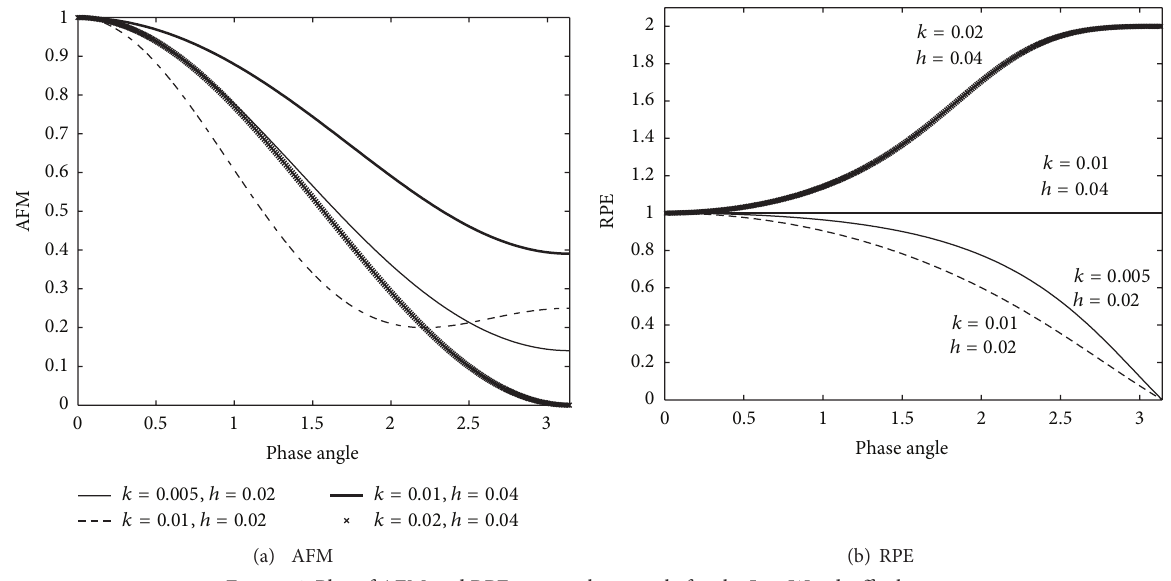
Figure 1: Plot of AFM and RPE versus phase angle for the Lax-Wendroff scheme.